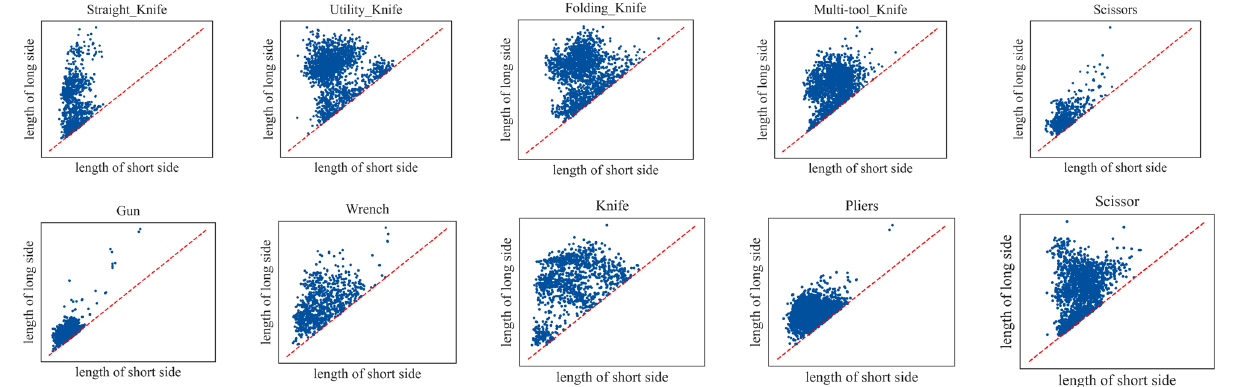
Figure 6. Comparison of length ratio of different categories under SIXray and OPIXray datasets.